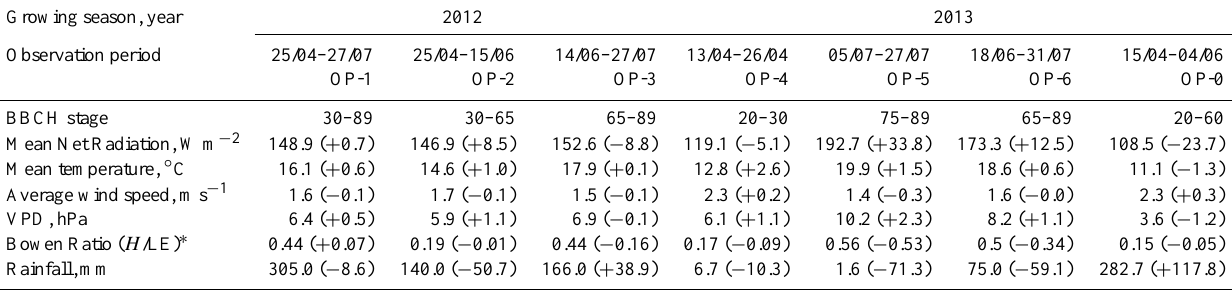
Table 2. Weather conditions during the vegetation periods 2012 and 2013. The numbers in brackets give the anomaly over an observation period with regard to the 5-year average from 2009 to 2013.